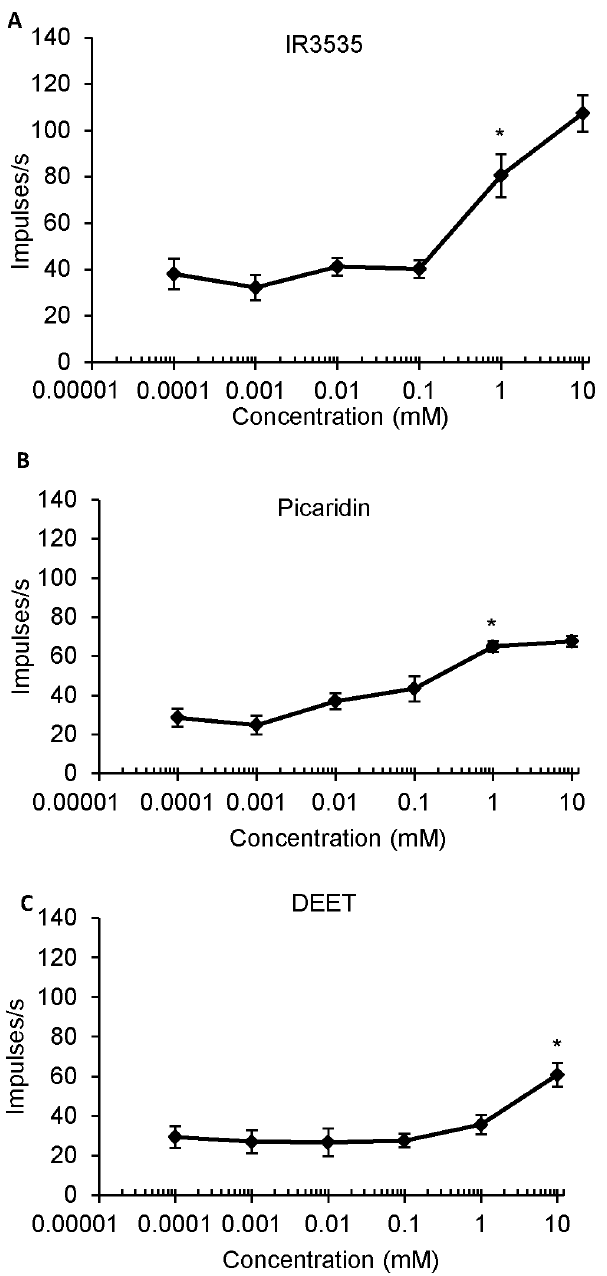
Figure 5. Dose-response curves constructed from numbers of impulses per second in the interval 0.05–1.05 s after initial stimulation by the deterrent-sensitive neuron elicited by increasing concentrations of (A) IR3535, (B) picaridin, and (C) DEET. An asterisk indicates the concentration at which a significant increase in the number of impulses occurred.